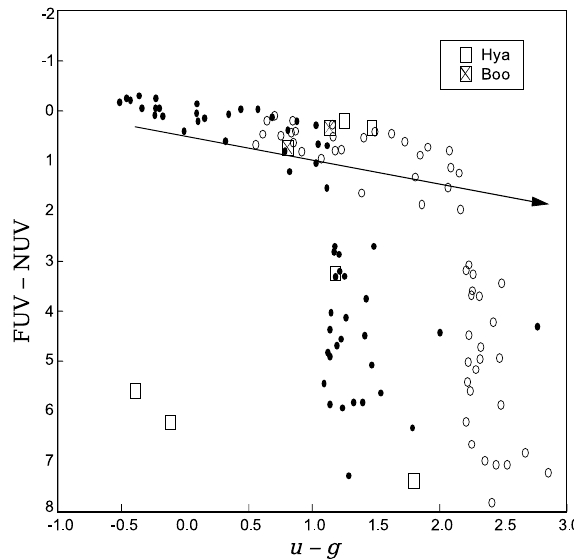
Fig. 3. SDSS/GALEX photometry. Squares: SDSS/GALEX objects in Bootes ( l = 353 ◦ , b = +68 ◦ , r = 0 : 1 ◦ , crossed squares) and Hydra ( l = 228 ◦ , b = +27 ◦ , r = 0 : 1 ◦ , open squares) areas. Filled circles are Pickles (1998) models recalculated into the AB magnitude system. Open circles are the same models but reddened by E B − V = 1. The arrow is the reddening